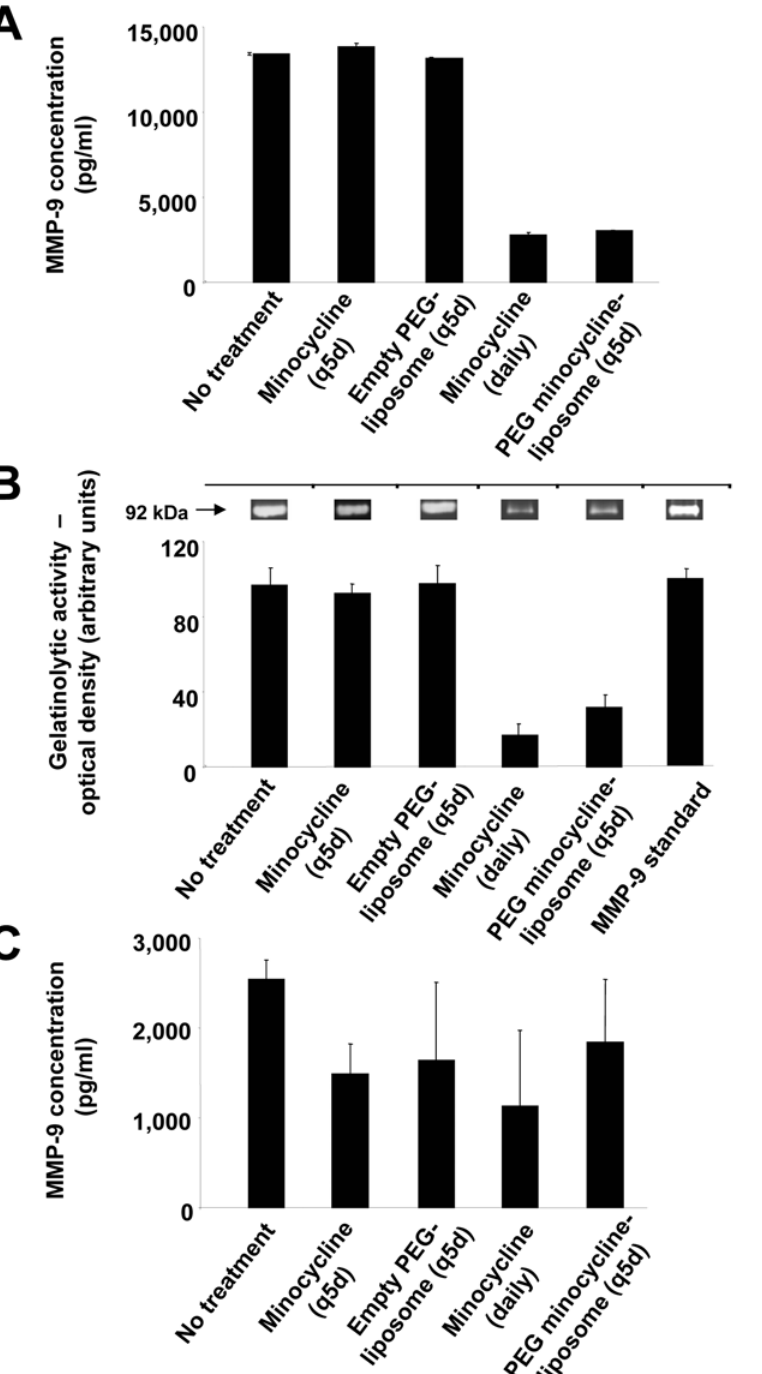
Figure 4. Effects of PEG minocycline-liposomes on the expression of matrix metalloproteinase (MMP)-9 in splenocytes and CNS- infiltrating leukocytes. The expression levels of MMP-9 were significantly down-regulated on day 20 after active induction of experimental autoimmune encephalomyelitis (EAE) in splenocytes of mice following treatment with daily intraperitoneal (i.p.) injections of minocycline, and after intravenous (i.v.) injections of PEG minocycline-liposomes every 5 days compared to experimental animals that received no treatment, that were treated with i.v. injections of empty PEG-liposome every five days, or with minocycline i.p. injections every five days, as shown by ELISA (A). The proteolytic activity of MMP-9 measured by zymography was also significantly diminished in mice treated daily with i.p. injections of minocycline and i.v. injections of PEG minocycline-liposomes every five days (B). MMP-9 protein expression in CNS mononuclear cells was not found to be significantly different between experimental groups (C).